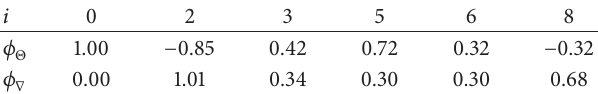
Table 1: Similarity metric and punishment